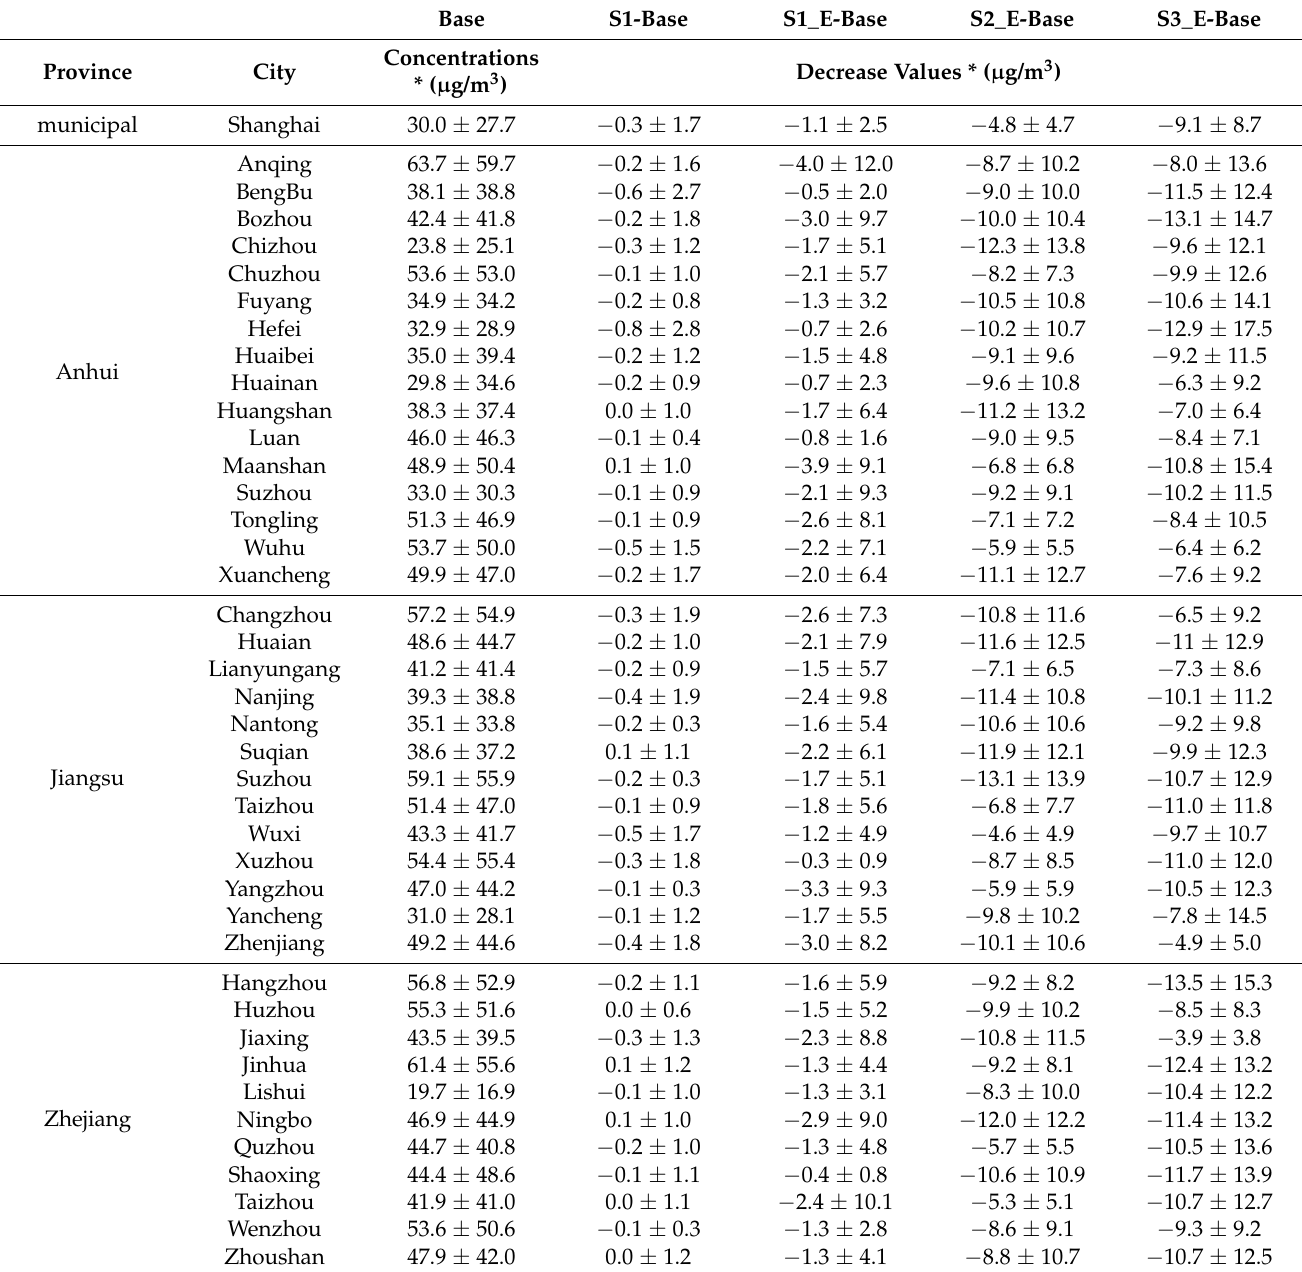
Table 3. Predicted average decrease values of winter PM 2.5 concentrations under the 4 control scenarios relative to the baseline in 41 main cities of YRD in